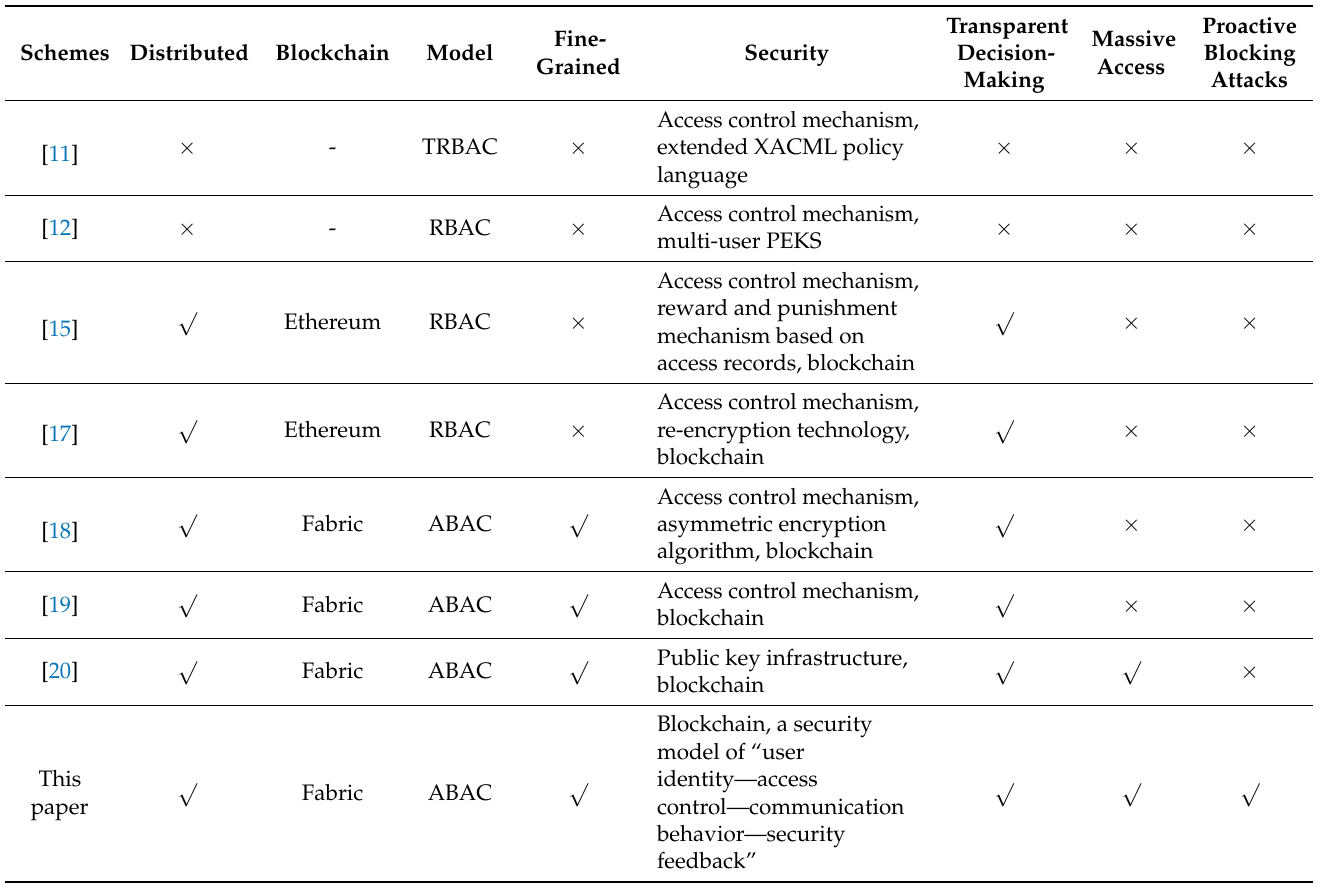
Table 4. Comparative analysis of this paper and existing research